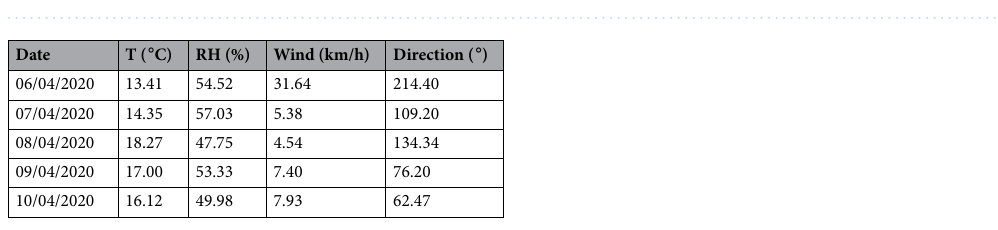
Table 1. Weather history data as mean daily values recorded in Villeneuve d’Ascq, F-59000, France at 60 masl (GPS location: 50.611208; 3.140441).